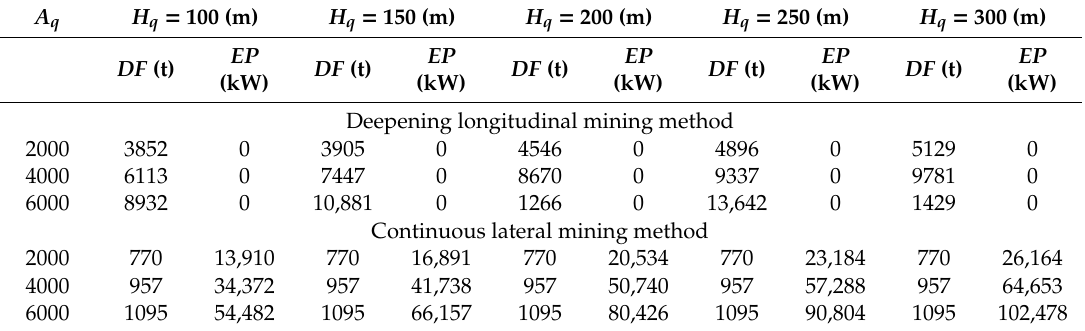
Table 4. Diesel fuel ( DF ) and electricity power ( EP ) consumption for overburden transporting by dump trucks and draglines respectively, in accordance with selected mining method, pit depth ( H q ) and annual capacity ( A q , thousand tons).